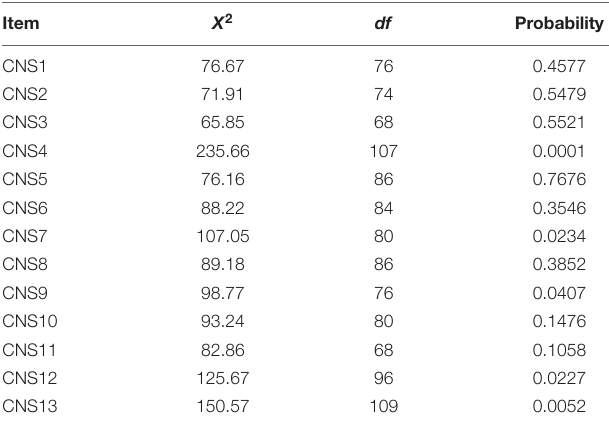
TABLE 2 | S- X 2 fit